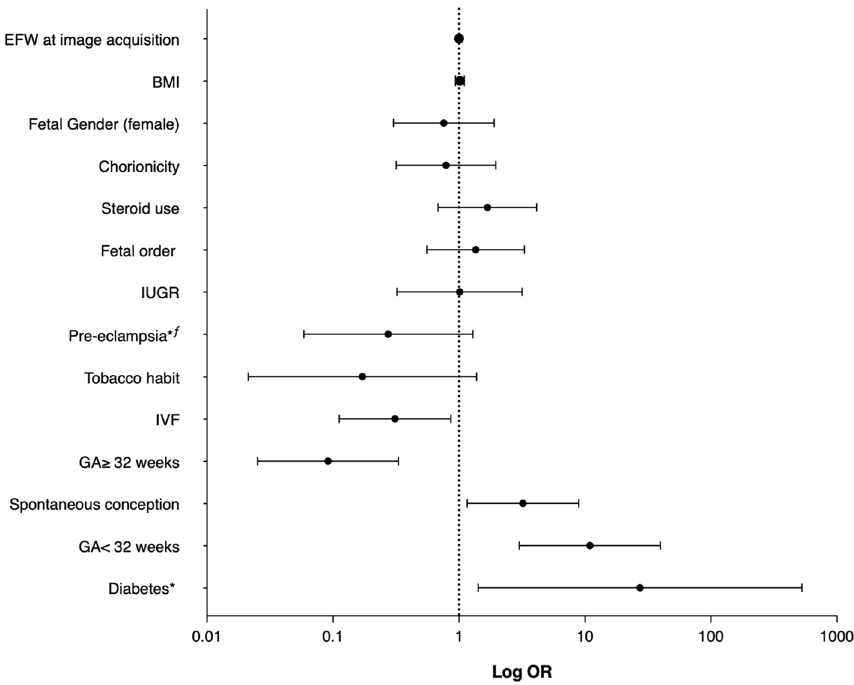
Figure 3. Individual risk for increased risk of neonatal respiratory morbidity according to QuantusFLM results in Group 2 (30.0–33.6 weeks). All p values and confidence intervals were calculated with robust bias-corrected logistic regression. *Adjusted for gestational age at the time of image acquisition. ƒ Adjusted for steroid use. EFW estimated fetal weight, BMI body mass index, IUGR intrauterine growth restriction, IVF in vitro fertilization, GA gestational